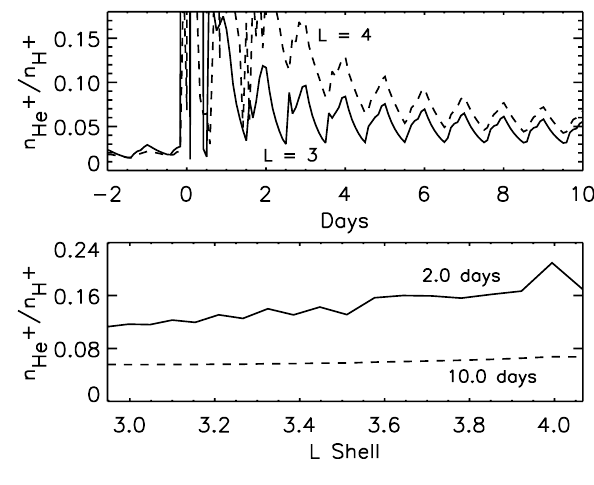
Fig. 5. He + / H + density ratio at the magnetic equator plotted versus time for L = 3 and L = 4 (top) and plotted versus L-shell for 2 days and 10 days after the storm (bottom). This simulation corresponds to longitude 0, summer, and high solar